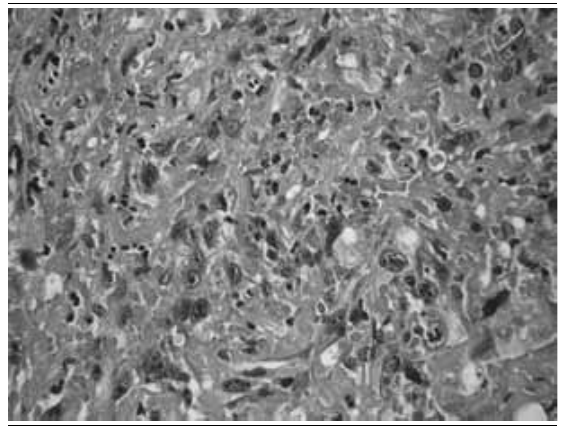
figurE 3 – HEE (HE, 100×) Epithelioid neoplastic cells with cytoplasmic lumens, sometimes containing